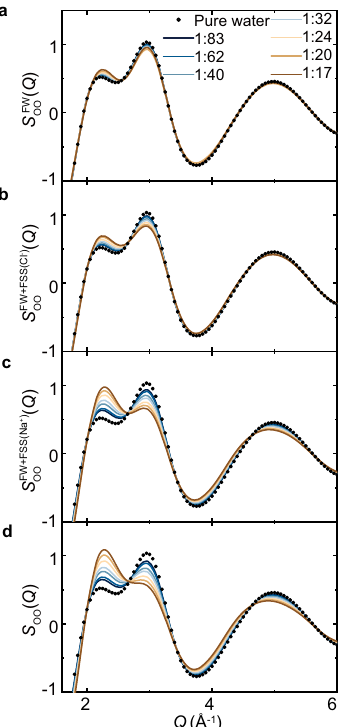
Fig. 4 Virtual diffraction experiments of NaCl solutions. The O – O structure factors contributed by a , the FW ð S FW ð Q ÞÞ . b The FW and the FSS OO of Cl − ð S FW þ FSS ð Cl (cid:3)Þ ð Q ÞÞ . c The FW and the FSS of Na + ð S FW þ FSS ð Na þÞ ð Q ÞÞ . OO OO d All water molecules in the system ð S OO ð Q ÞÞ . The 1:10 results are not presented because the excluded volume correction is inapplicable 17